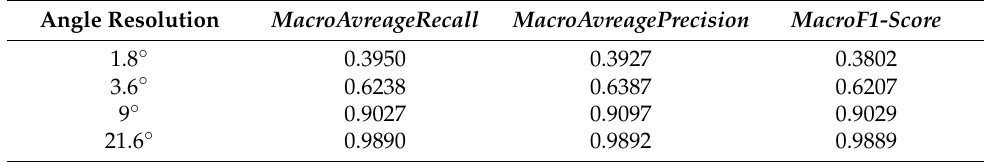
Table 8. Values of parameters measured the quality of the predictive model.